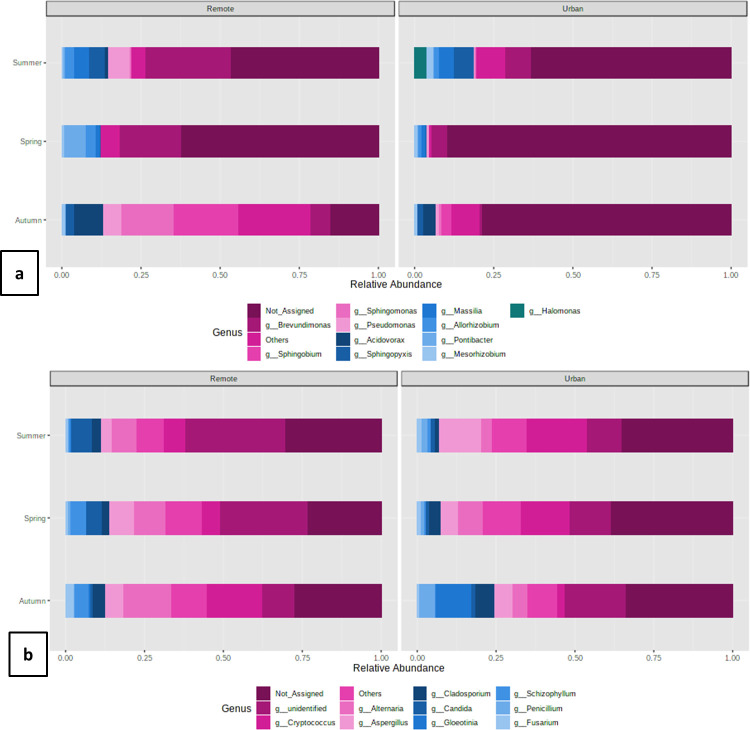
Bar plots representing the seasonal variations in relative abundances of predominant genus of (a) Bacteria and (b) Fungi. The taxa above 100 OTU counts are represented on the plots. The rest are binned together as others.